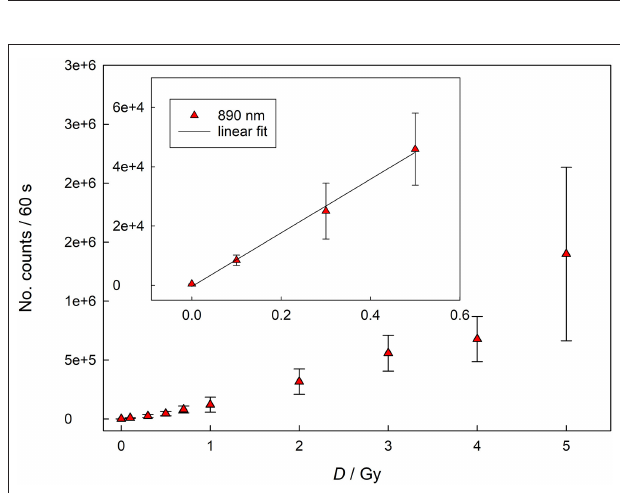
FIGURE 3 | Dose response for infrared (890nm) stimulation (data acquired with Reader 2).